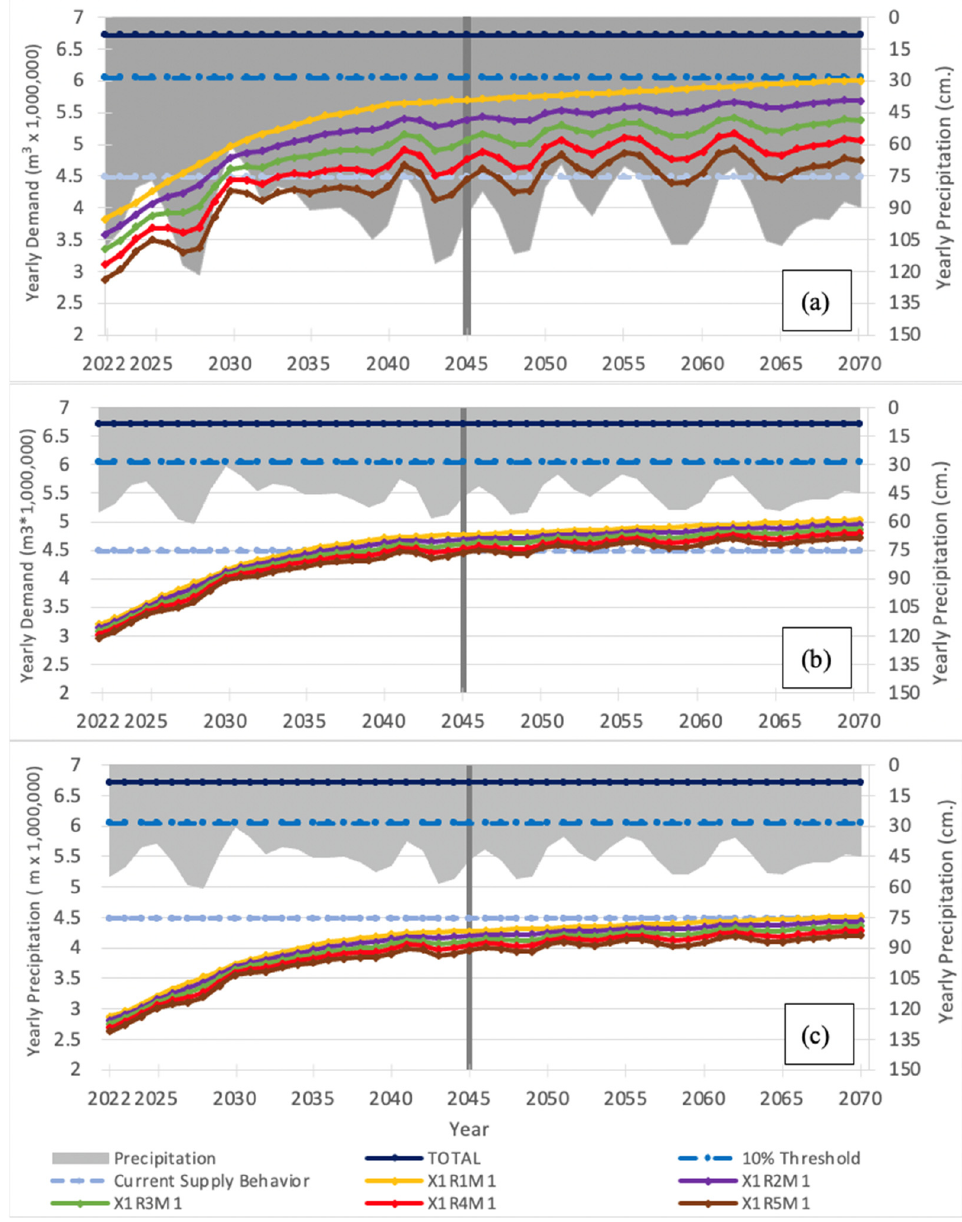
Figure 5. Impact of Interventions Based on Drought Scenarios. ( a ) Base case, ( b ) Drought scenario one, ( c ) Drought scenario two .